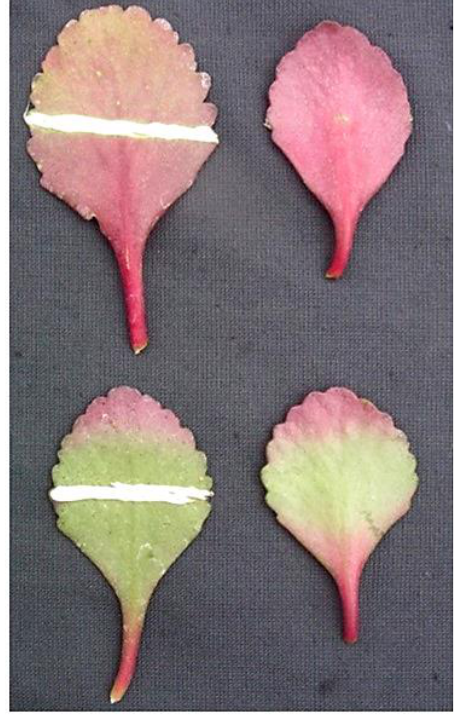
Figure 3. Effect of 0.5% JA-Me in lanolin paste applied on the adaxial or abaxial side of detached leaves of K. blossfeldiana on anthocyanins accumulation. The treated leaves were kept in an inverted position (the abaxial side on the lower side) for 4 days in natural light. Upper row: lanolin applied on the abaxial side of detached leaves ( left ) and lanolin applied on the abaxial side ( right ) and kept in an inverted position. Lower row: JA-Me applied on the adaxial side of detached leaves ( left ) and JA-Me applied on the adaxial side ( right ) and kept in an inverted position.